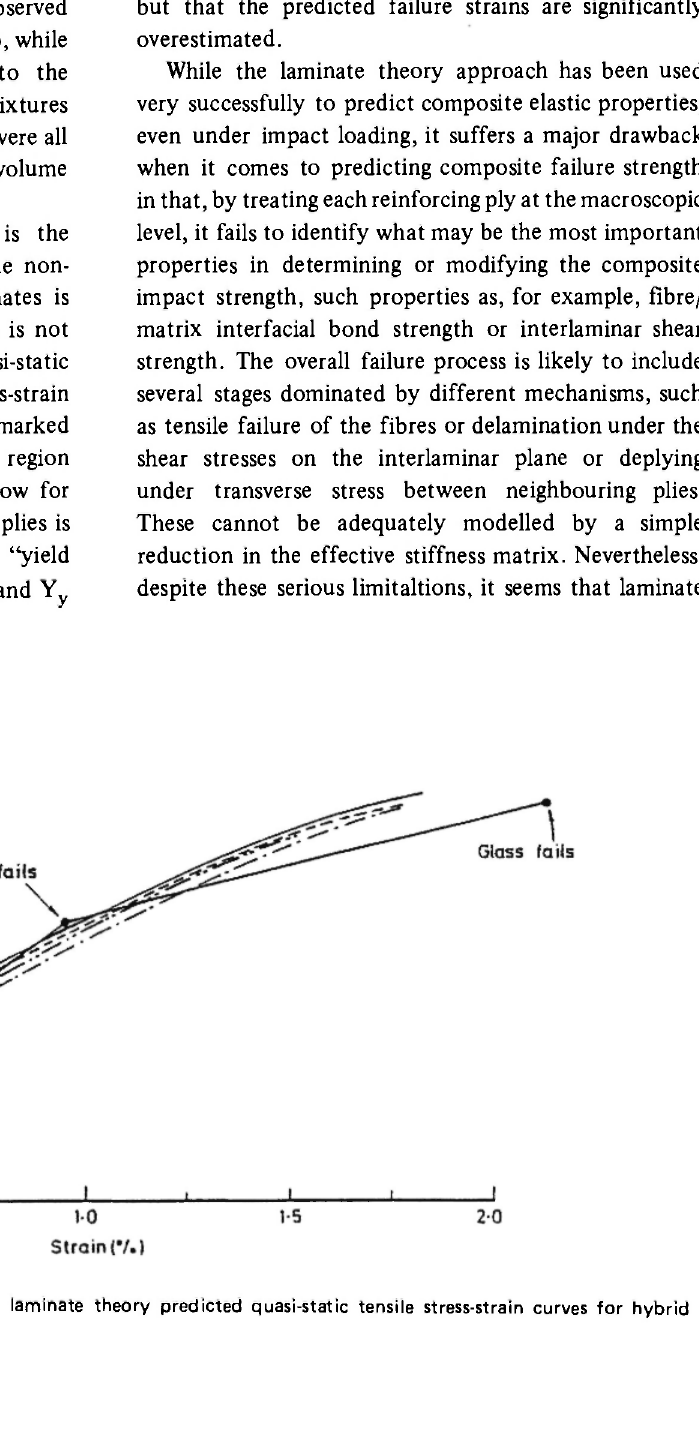
Fig. 24: Comparison of experimentally measured and laminate theory predicted quasi-static tensile stress-strain curves for hybrid woven carbon/glass specimen (ref.